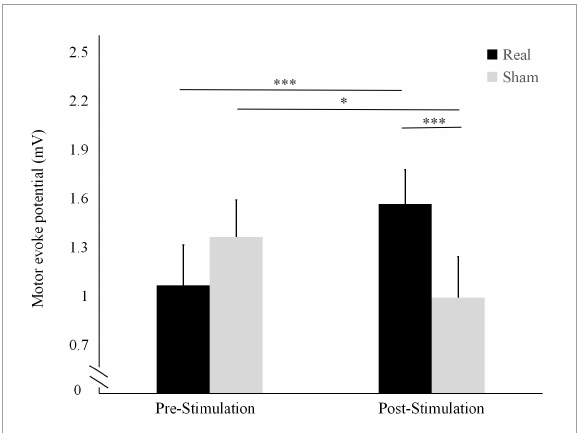
FIGURE2 Differences in motor-evoked potentials (MEP) amplitude before and after the real and sham stimulation sessions. *** P < 0.001, * P < 0.05.